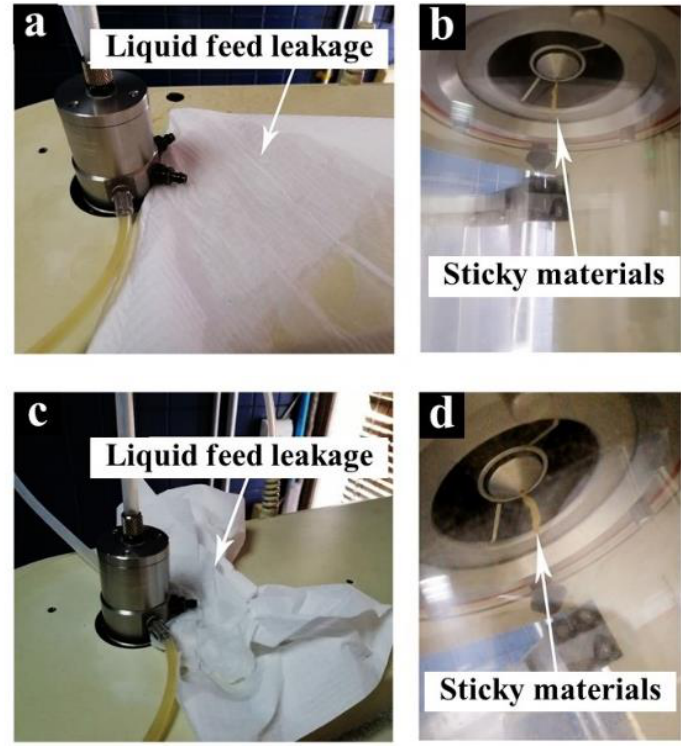
Fig. 1: The presence of liquid feed leakage and sticky materials in S1 (a & b) and S3 (c & d) formulations. Fig. 2 represents the physical appearance of microcapsules obtained. The forms were in fine powder with characteristic odor and bitter taste. The color was turned from brownish orange to light brown when the level